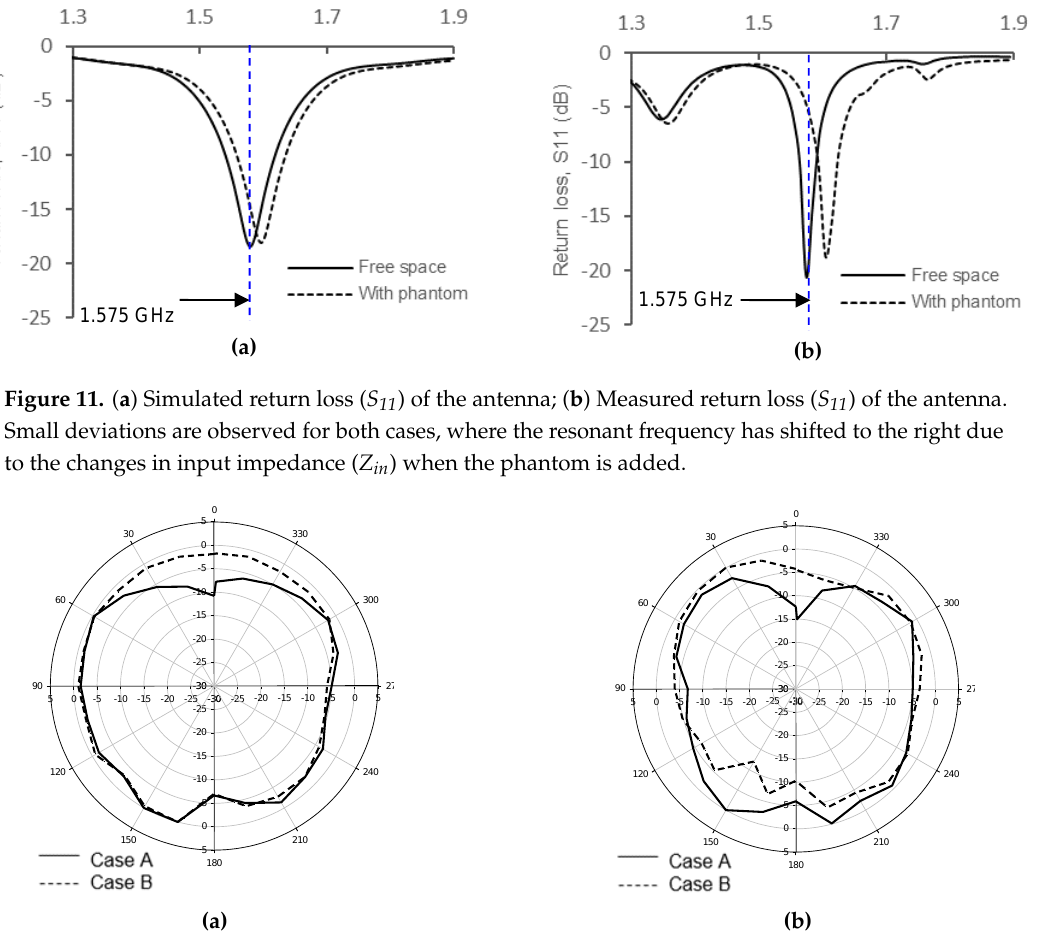
Figure 12. Measured radiation pattern: ( a ) Electric field plane (E-plane); ( b ) Magnetic field plane (H-plane). Slight deformation is observed due to the loss in radiated power that is absorbed by the lossy medium.